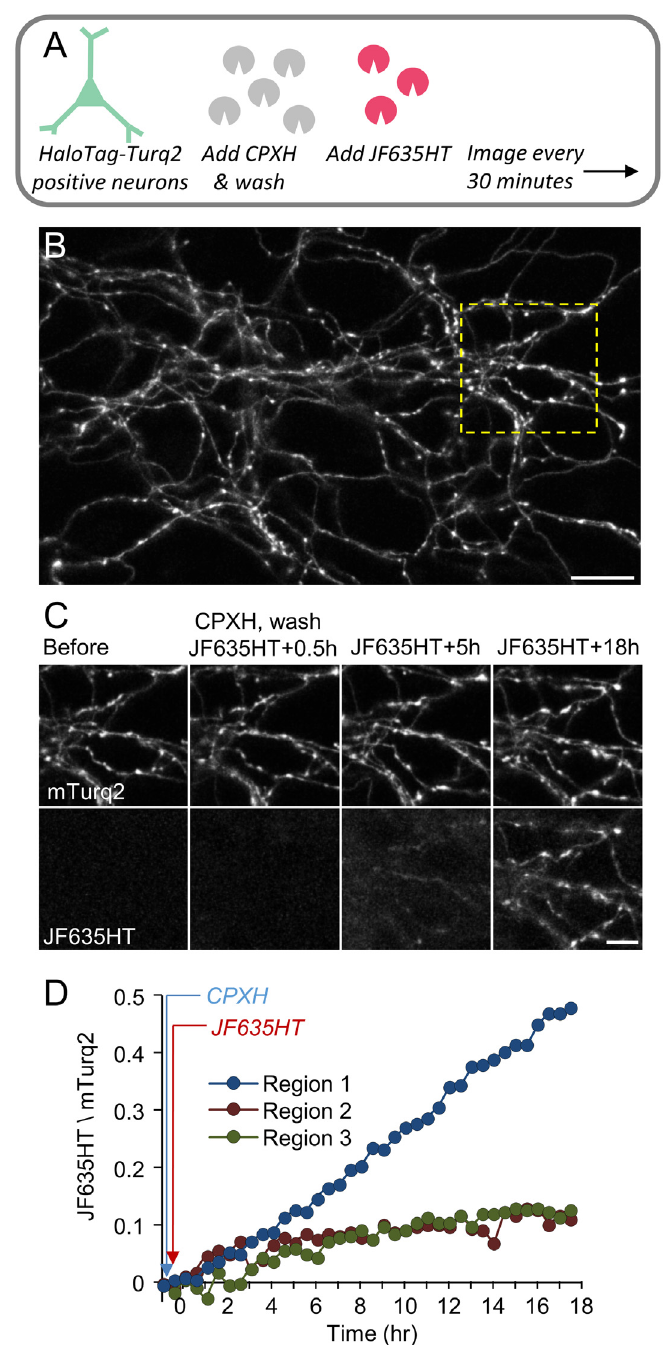
Figure 5. CPXH improves the reliability of newly synthesized protein detection in axons of living neurons. ( A ) Imaging of axon ‘beds’ belonging to neurons expressing HaloTag-mTurq2. Neurons were treated as in Figure 4. ( B ) Example of axon bed belonging to mTurq2- positive cortical neuron(s). Bar, 20 µm. ( C ) Gradual changes in JF635HT labeling over time in axons enclosed in the yellow rectangle in B . Note the negligible labeling immediately after exposure to JF635HT. Bar, 10 µm. ( D ) ratio of JF635HT to mTurq2 fluorescence in mTurq2-positive axons (average of 10 regions per field of view). Background corrected JF635HT/mTurq2 fluorescence ratios for three different axon beds are shown. Images in ( B ) and ( C ) belong to Region 1. Note the slow increase in JF635HT fluorescence, as might be expected in cellular regions at significant distance from the neurons’ major sites of protein synthesis (i.e., the cell